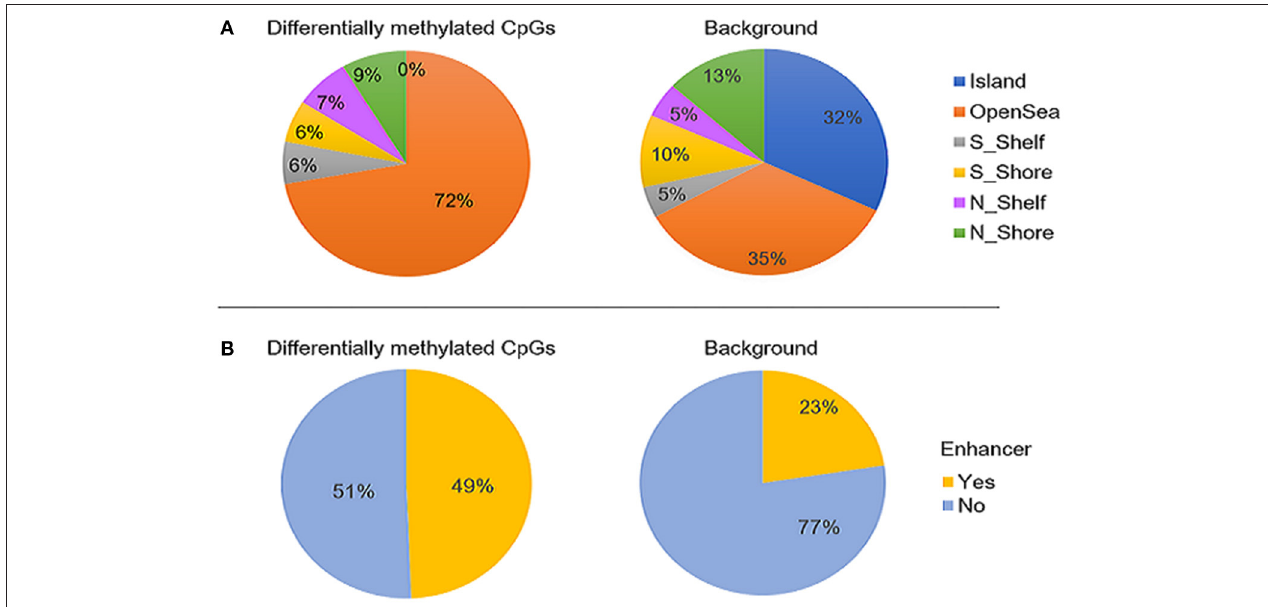
FIGURE 2 | The genomic distribution of the 400 differentially methylated CpG sites identified between ASD cases ( n = 265) and controls ( n = 122, left) compared to the background set of all probes that retained after probe filtering ( n = 427,137) (right). (A) proportion CpG sites in relation to CpG islands and (B) proportion of CpGs overlapping enhancer regions. The differentially methylated sites were found to be significantly enriched in open sea and enhancers ( p -values < 0.05) and depleted in CpG islands ( p -value < 0.01). “Island” is CpG island; N_shore and S_shore are north (upstream) and south (downstream) shores, i.e. 2kb regions flanking island; N_shelf and S_shelf are north (upstream) and south (downstream) shelves, i.e. 2kb regions flanking island